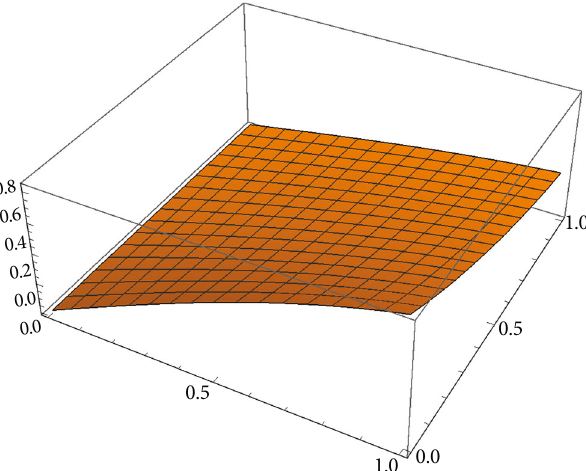
Figure 2: Approximate solution for Example 5.